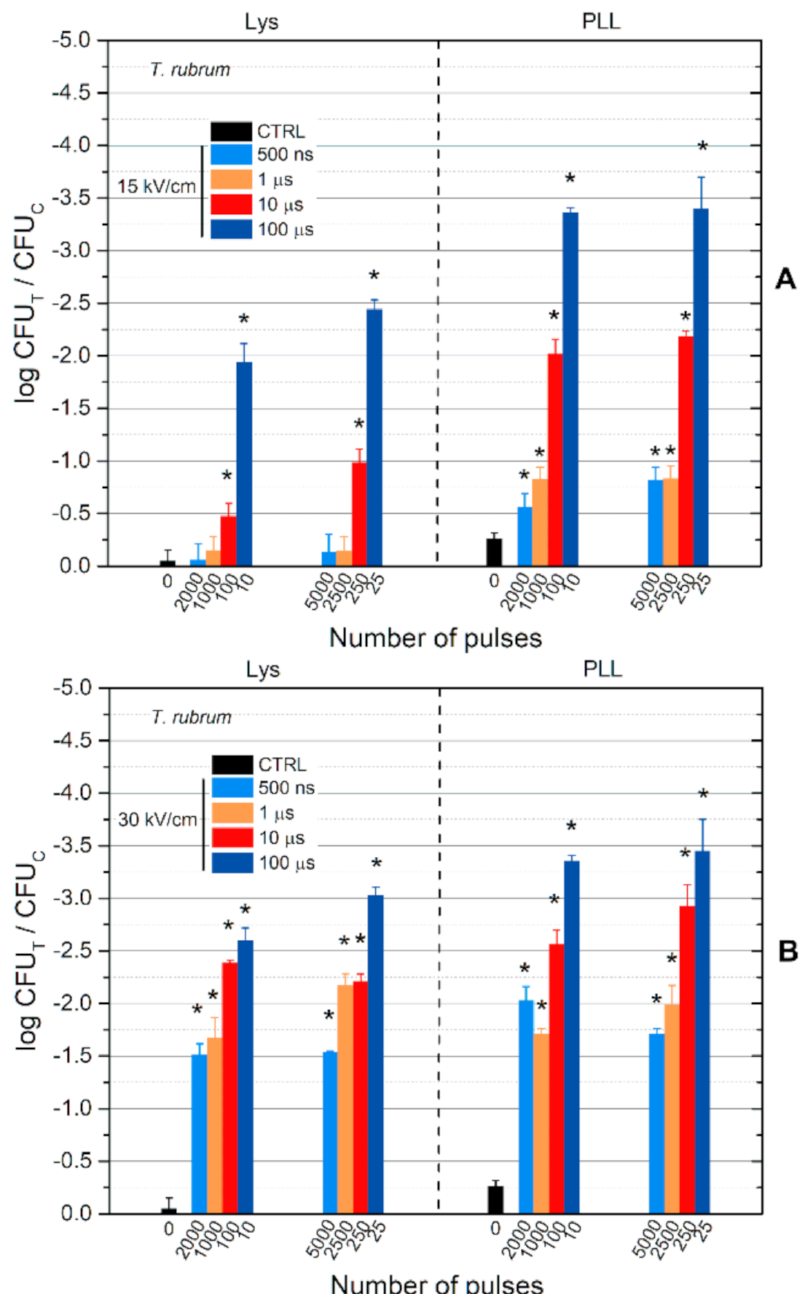
Figure 2. The antimicrobial efficacy of L-lysine and poly-L-lysine with pulsed electric field treatment against T. rubrum , where ( A ) 15 kV/cm treatment; ( B ) 30 kV/cm treatment. Asterisk (*) represents statistically significant ( p < 0.05) difference versus Lys or PLL treatment, respectively. CTRL—samples with Lys or PLL without PEF